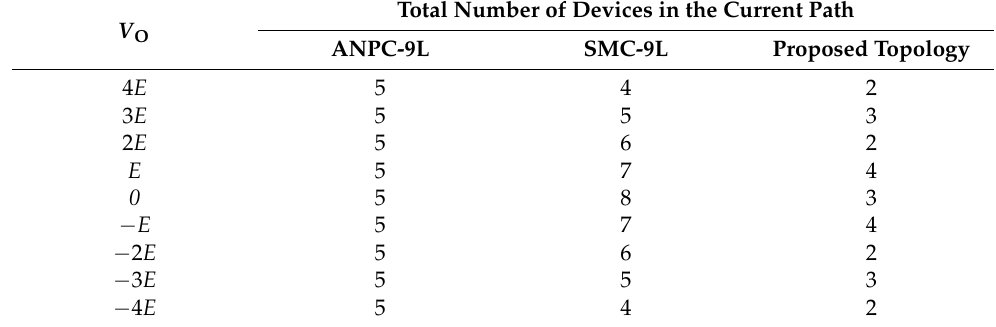
Table 3. Comparison of the total number of devices in the current